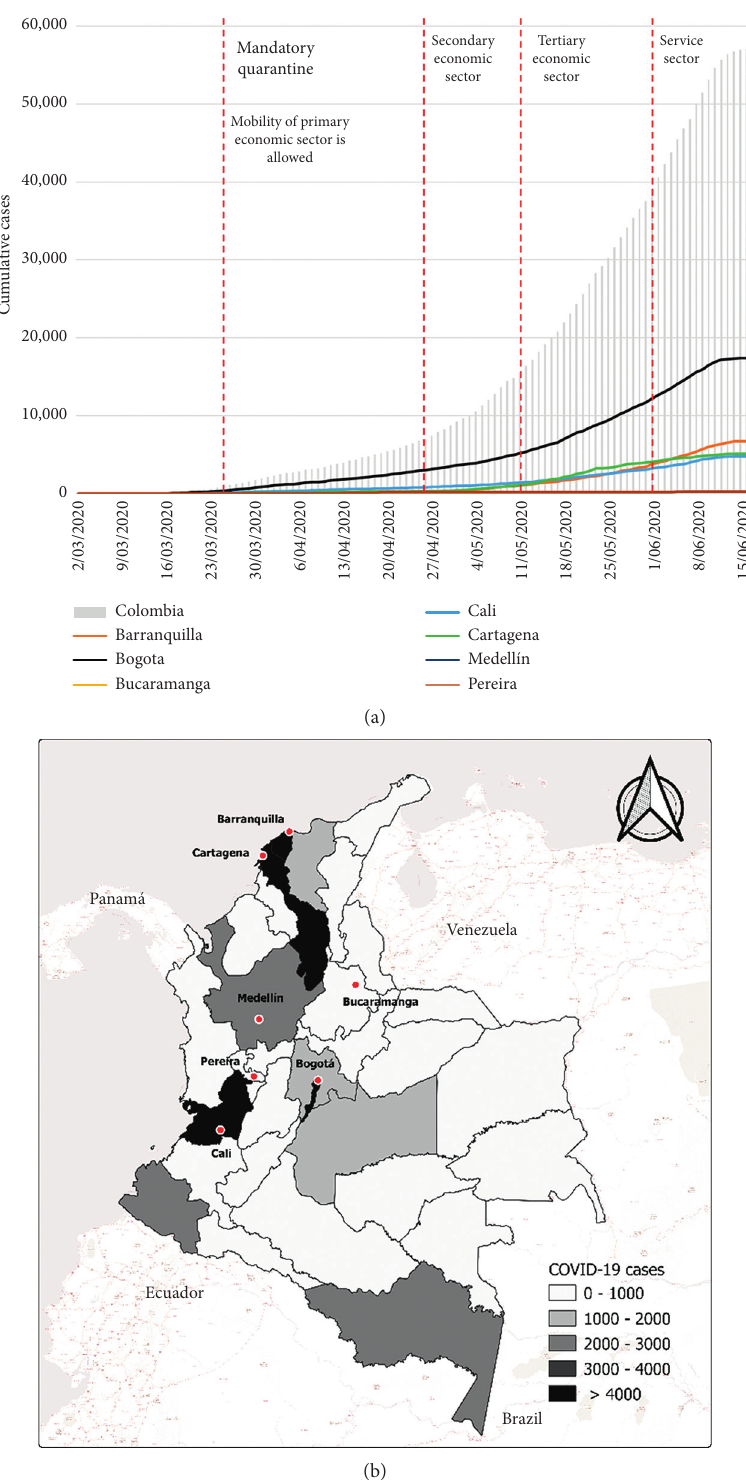
Figure 1: Cumulative cases and geographical distribution of confirmed COVID-19 cases in Colombia during the March to June 2020 period. (a) Cumulative confirmed cases in Colombia up to June 16. (b) Geographical distribution of confirmed cases in Colombia up to June